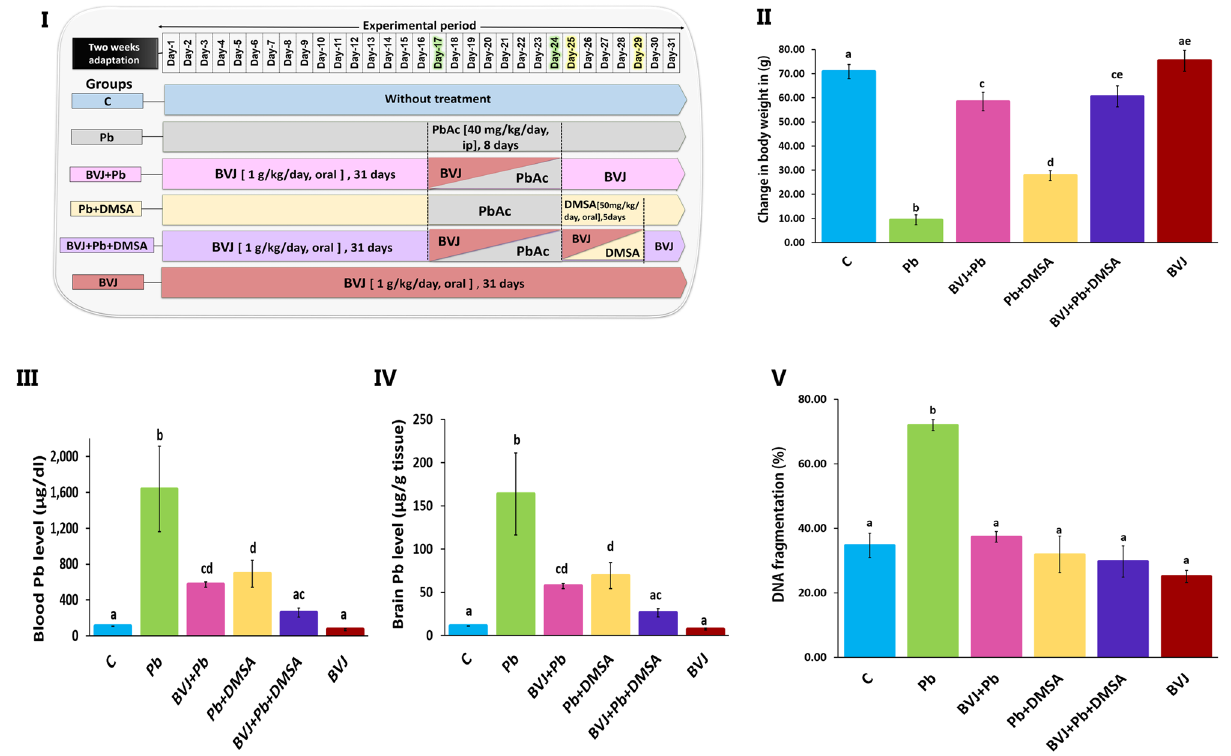
Figure 2. The ameliorating effects of Beta vulgaris juice (BVJ), dimercaptosuccinic acid (DMSA), and their combination (BVJ + DMSA) on the blood and brain Pb and DNA fragmentation in Pb-intoxicated rats. Where ( I ): An illustration of the current experimental design, ( II ): the change in the body weight of rats in all the studied groups, ( III ): the blood in all the studied groups, ( IV ): the brain Pb levels in all the studied groups, and ( V ) the % of DNA fragmentation level in all the studied groups. The results are shown as mean ± SE (n = 8). Different letters for the same parameter are significantly different at p < 0.05. C control,; ip